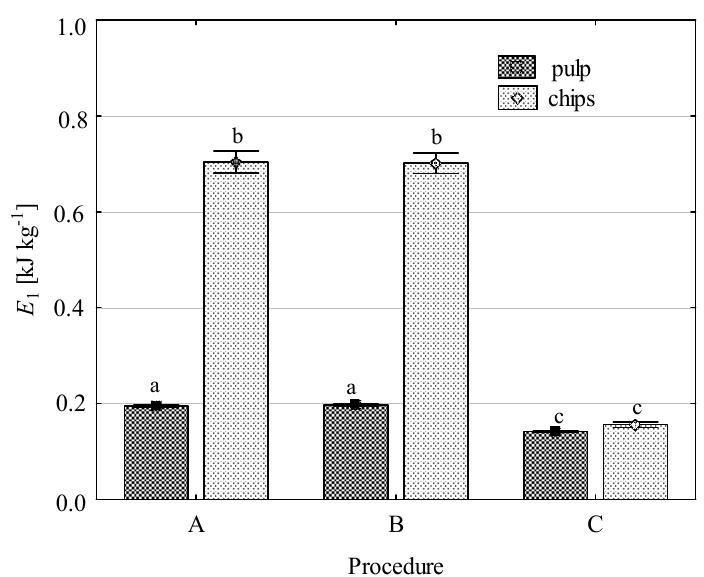
Figure 7. Impact of applied procedures on the specific energy E 1 in the first pressing cycle of ground celeriac root. Abbreviations, as in Figure 3. a, b, and c—average values marked with the same letter show no statistically significant difference ( p ≤ 0.05).